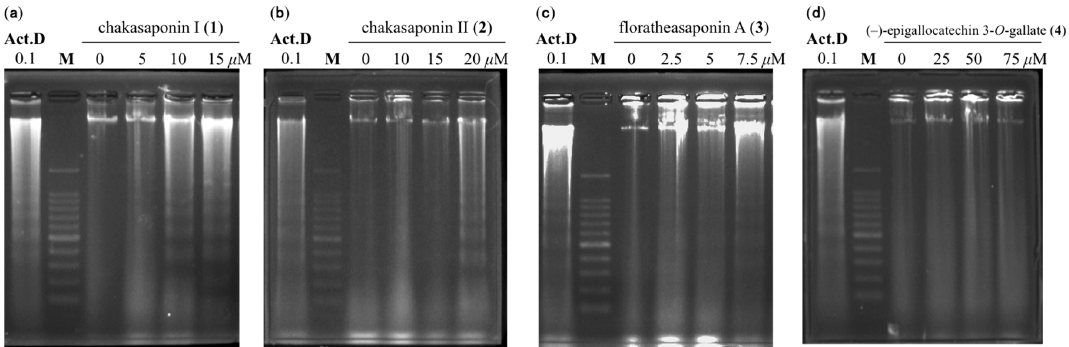
Figure 5. DNA fragmentation in HSC-2 cells treated with 1 – 4 and actinomycin D. Representative DNA fragmentation of HSC-2 treated with ( a ) 5, 10, and 15 µM of 1 ; ( b ) 10, 15, and 20 µM of 2 ; ( c ) 2.5, 5, and 7.5 µM of 3 ; ( d ) 25, 50, and 75 µM of 4 , and (Act.D) 0.1 µM of actinomycin D for 48 h; (M) represents a marker (100 bp DNA ladder); commercial actinomycin D was purchased from Wako Pure Chemical Industries, Ltd. (Osaka, Japan).